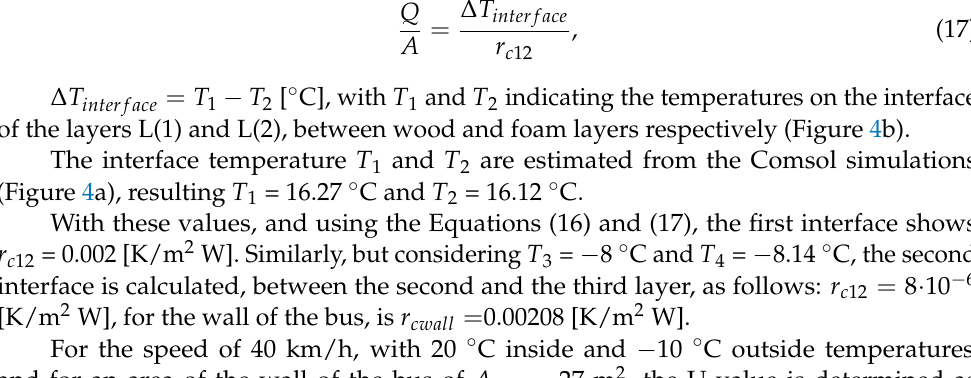
Table 5. U values and heat loss through the bus structure into the ambient.